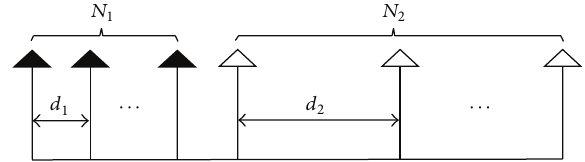
Figure 1: A 2-level nested array with 𝑁 1 sensors in the inner ULA and 𝑁 2 sensors in the outer ULA, with spacings 𝑑 1 and 𝑑 2 ,